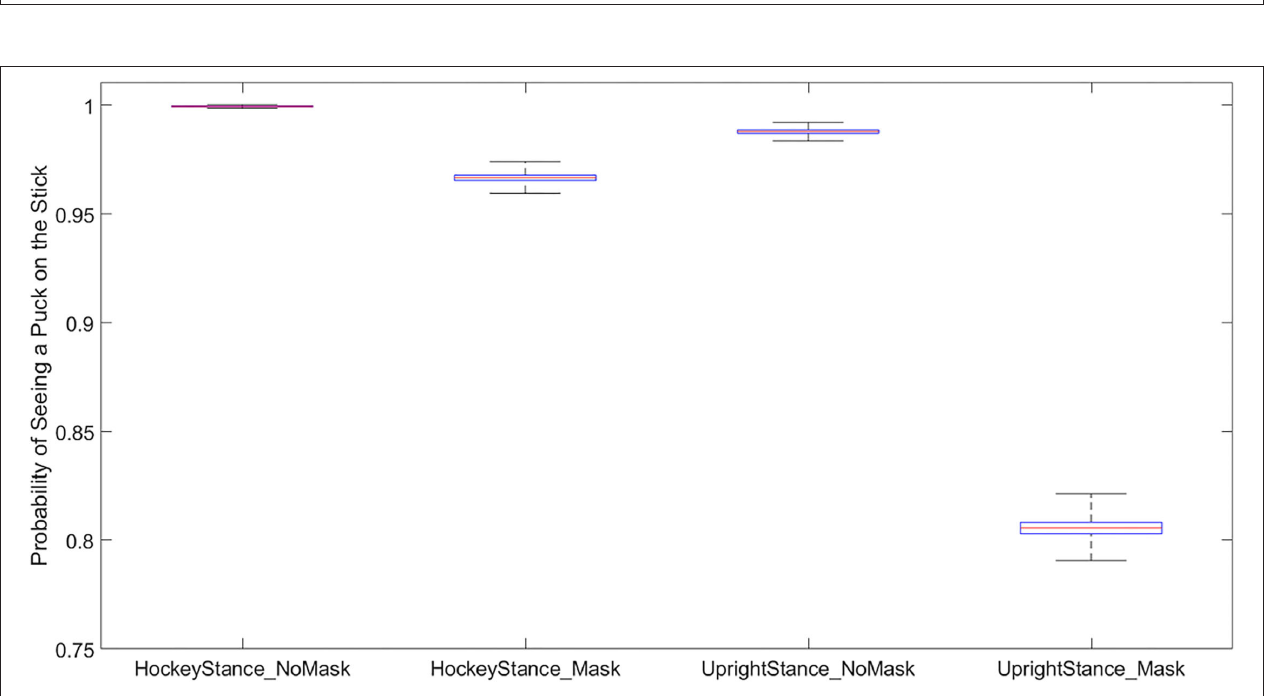
FIGURE 2 | Visual angle thresholds for the no mask (light gray) were significantly smaller than for the masked (dark gray) condition. Group averages represented by a bolded circle (no mask) and a bolded square (masked). Error bars represent standard error.